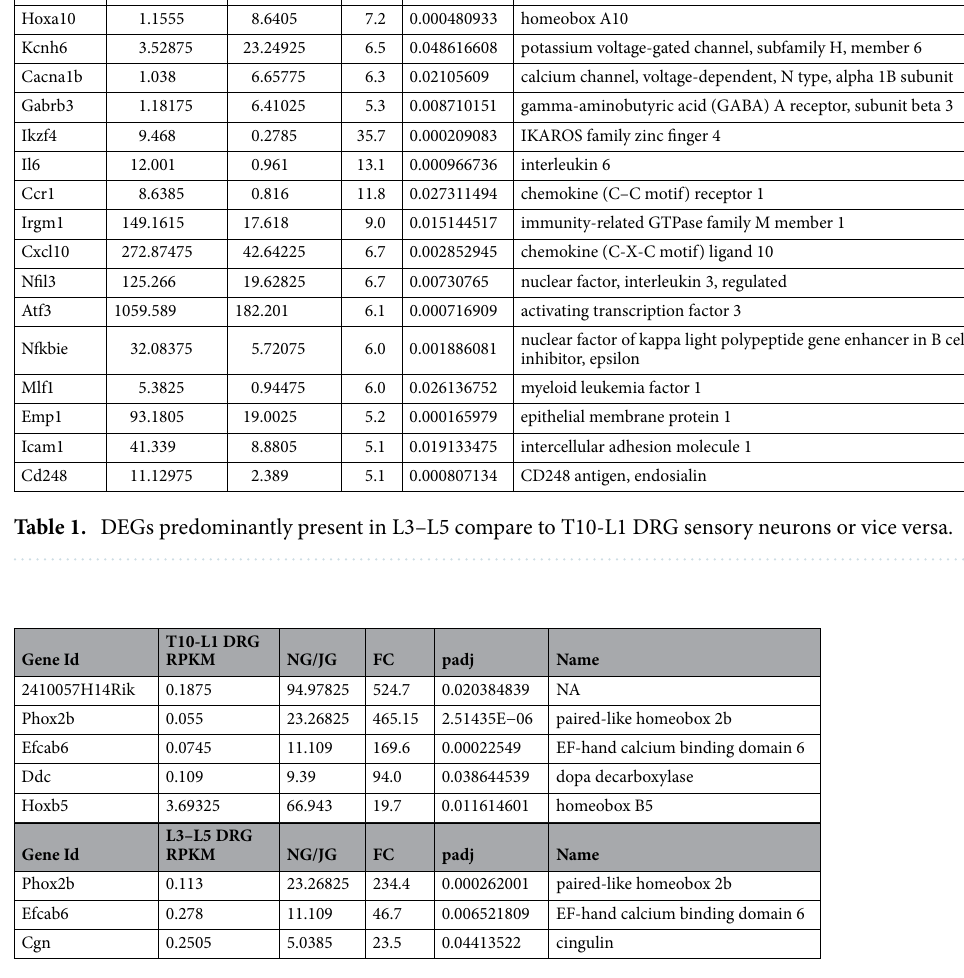
Table 2. DEGs predominantly present in NG/JG compare to L3–L5 and T10-L1 DRG sensory